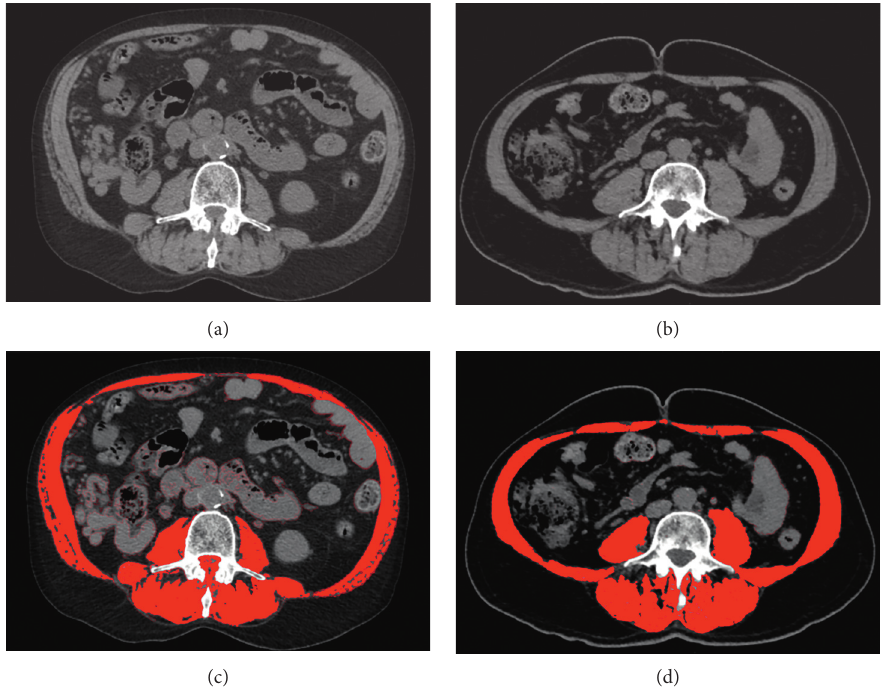
Figure 3: Computed tomography images of two different patients, one affected by HCC (a) and one affected by pancreatic cancer (b). Both patients demonstrate imaging sign of sarcopenia using the public domain software (ImageJ) (B